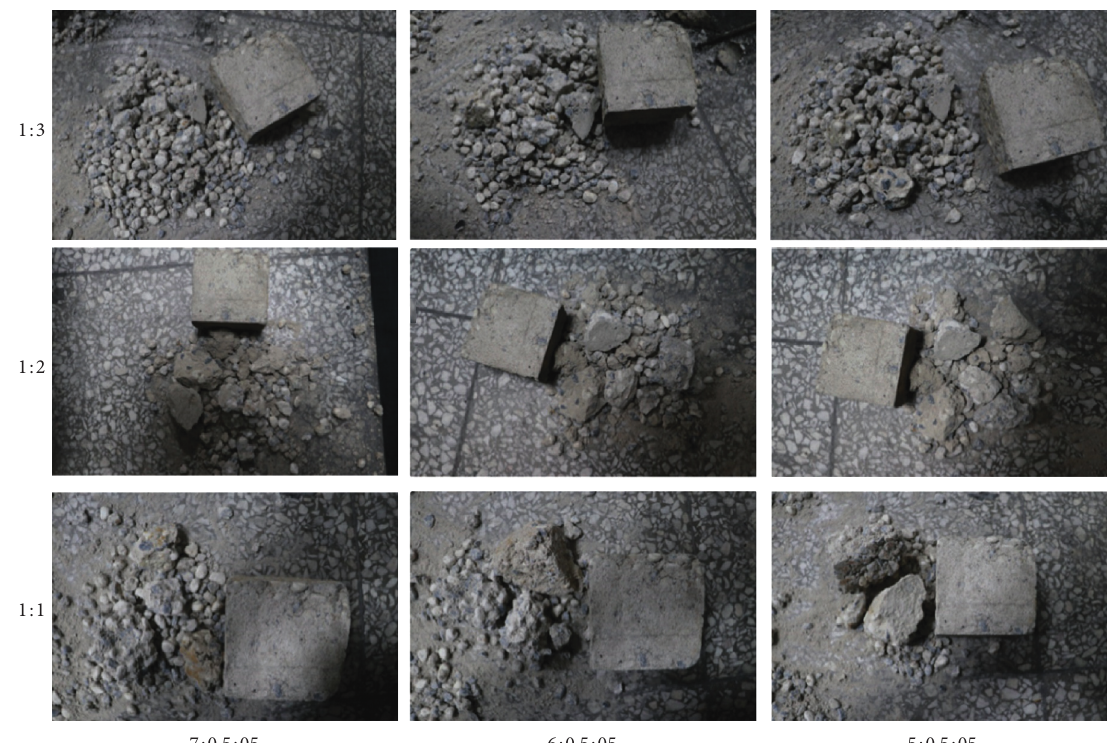
Figure 6: Free-falling